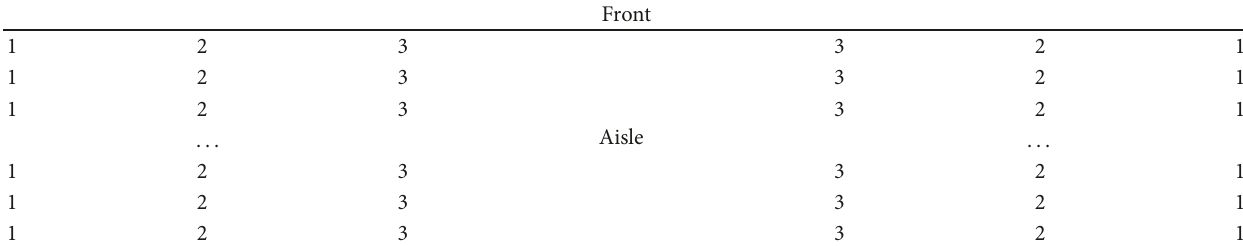
Table 3: The scheme of the Wilma strategy